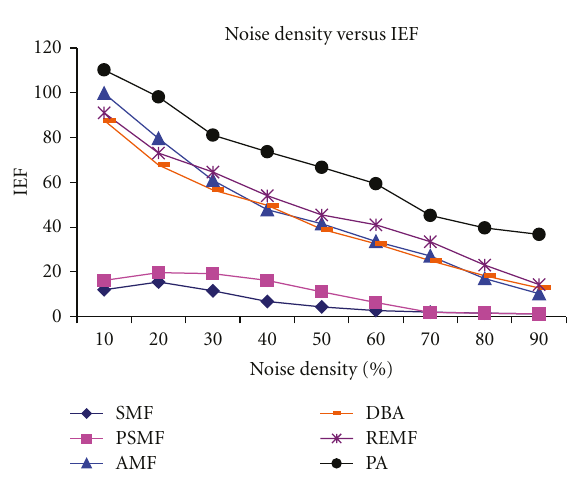
Figure 10: Noise density versus IEF for cameraman image.